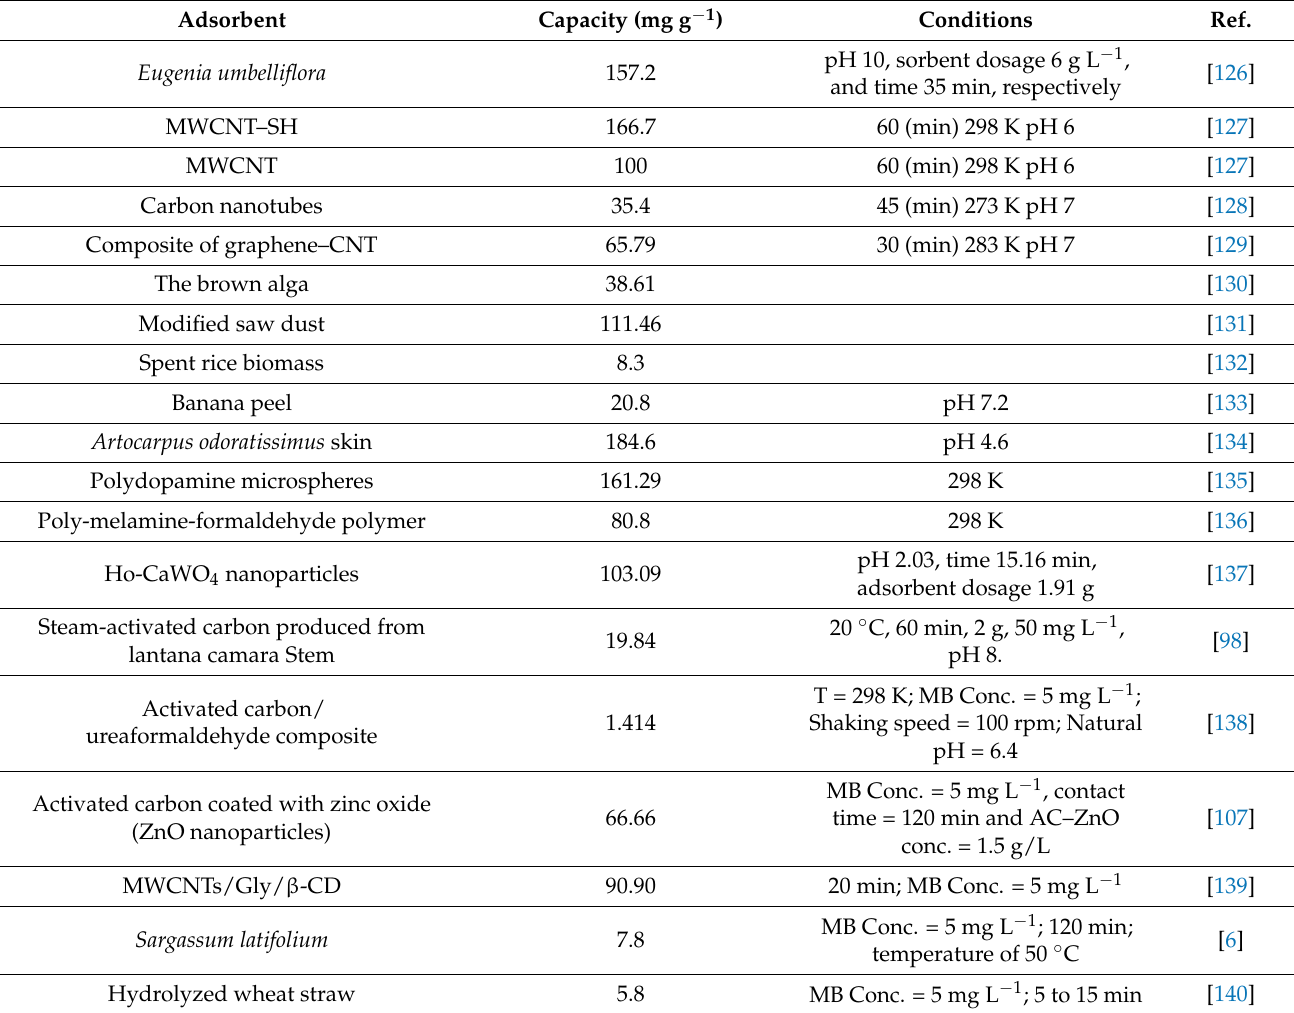
Table 6. Comparison of the maximal uptake capacity of MBD with other